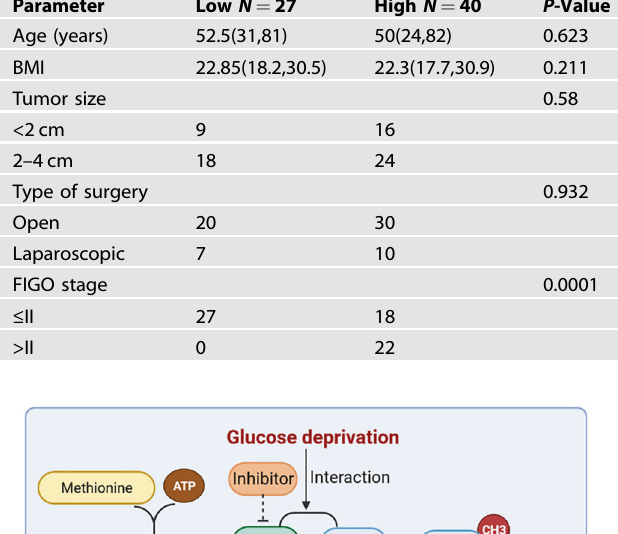
Table 1. Clinical characteristics of cervical cancer patients with PDCD6 expression.